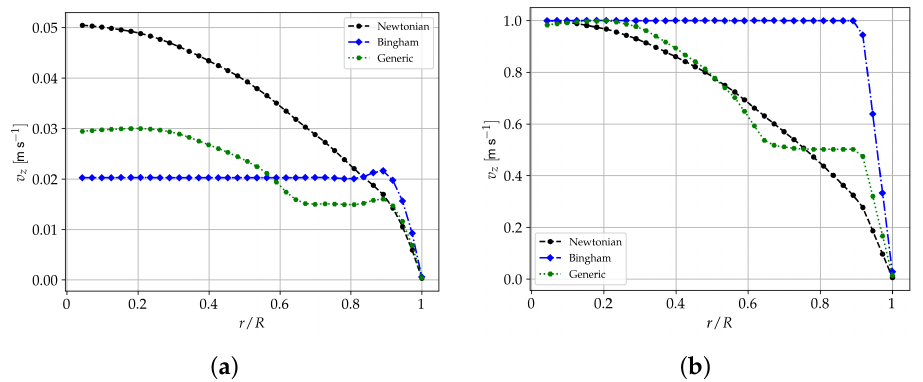
Figure 22. ( a ) Velocity profiles in axial direction in the pipe flow. profiles obtained for Newtonian, Bingham and Generic cases. ( b ) Normalised axial velocity profiles.